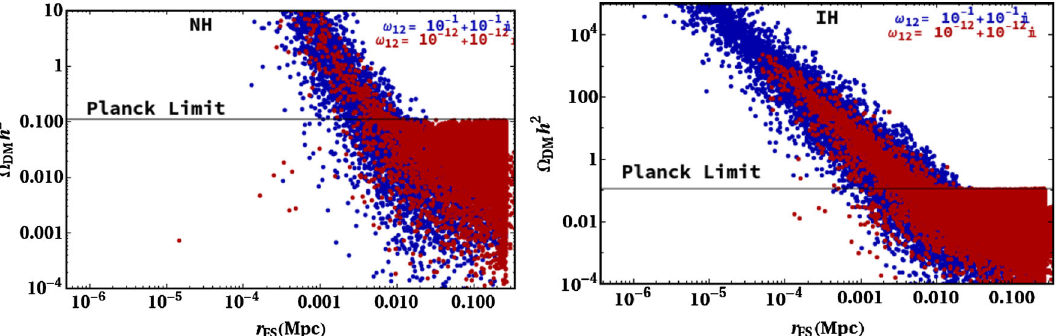
Fig. 11 Theplotshowsvariationoffreestreaminglengthw.r.ttherelicabundanceof ξ fortwodifferentvaluesofarbitraryangle ω 12 andbenchmark values of ω 13 = 10 − 3 + 10 − 3 i and ω 23 = 10 − 2 + 10 − 2 i for